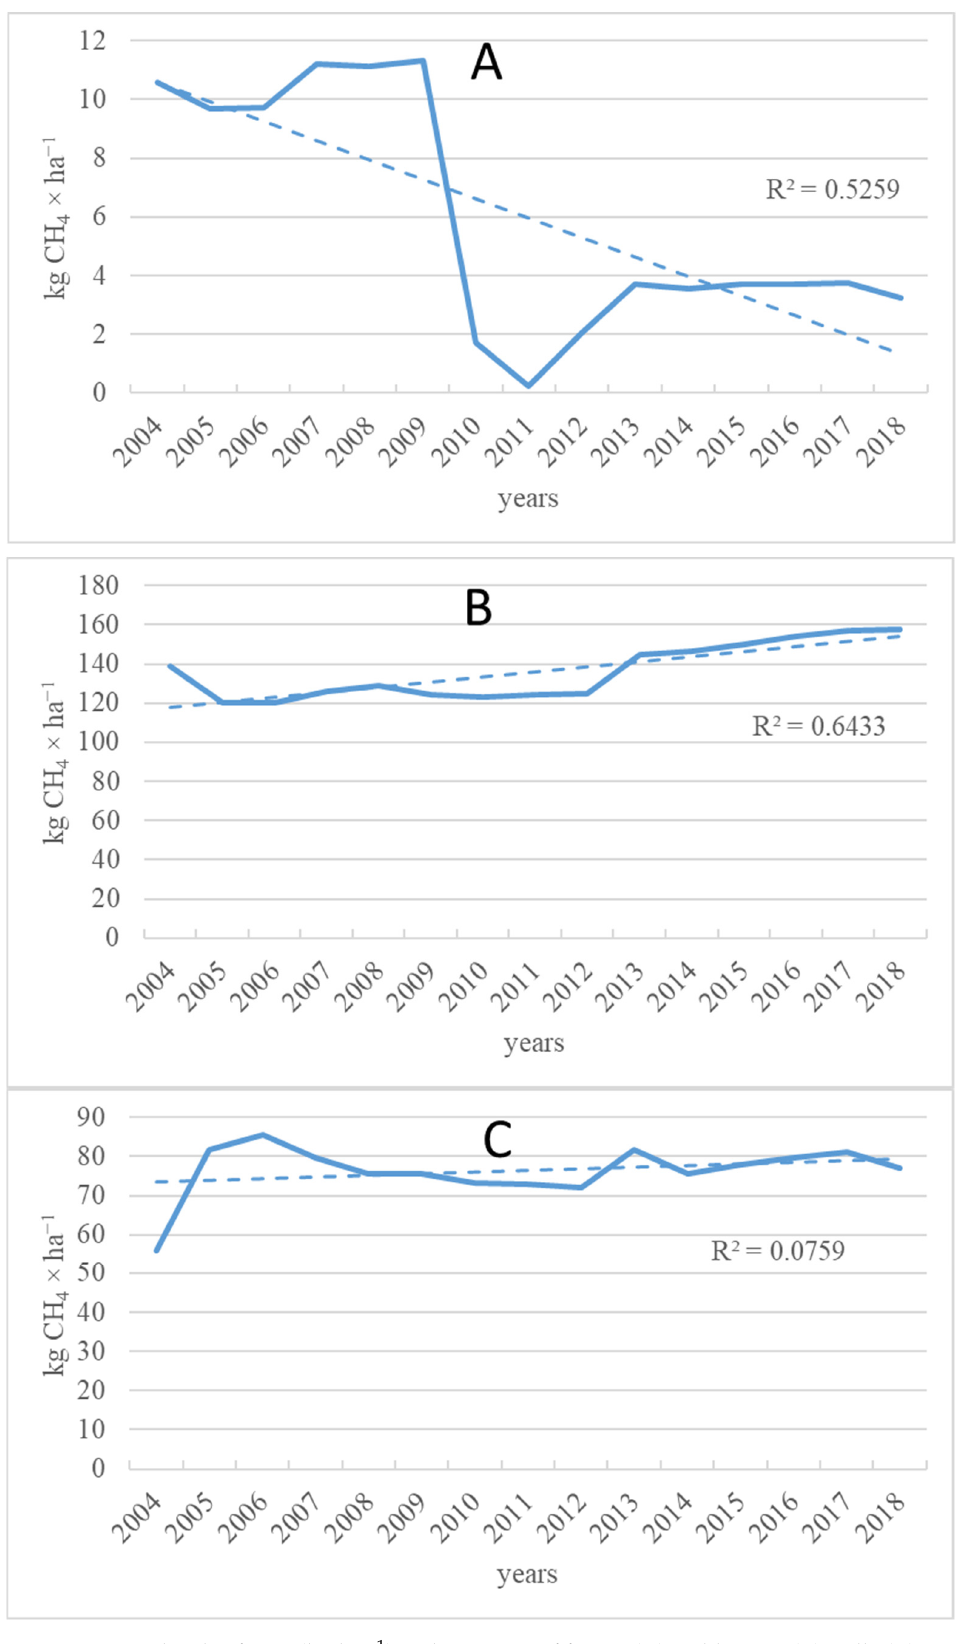
Figure 1. Emission levels of CH 4 (kg·ha − 1 ) at three types of farms: ( A ) Field crops; ( B ) Milk; ( C ) Mixed.